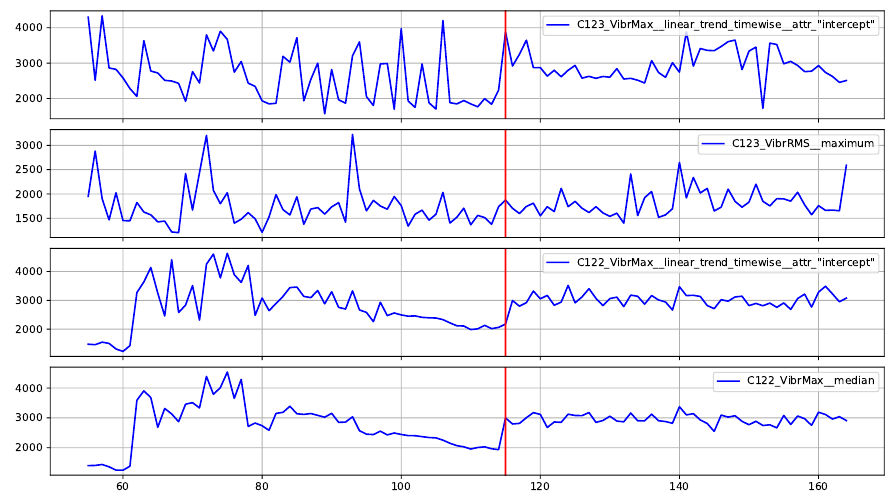
Figure 16. Selected excerpt from the plot of the most significant features indicated by the explanatory model in Figure